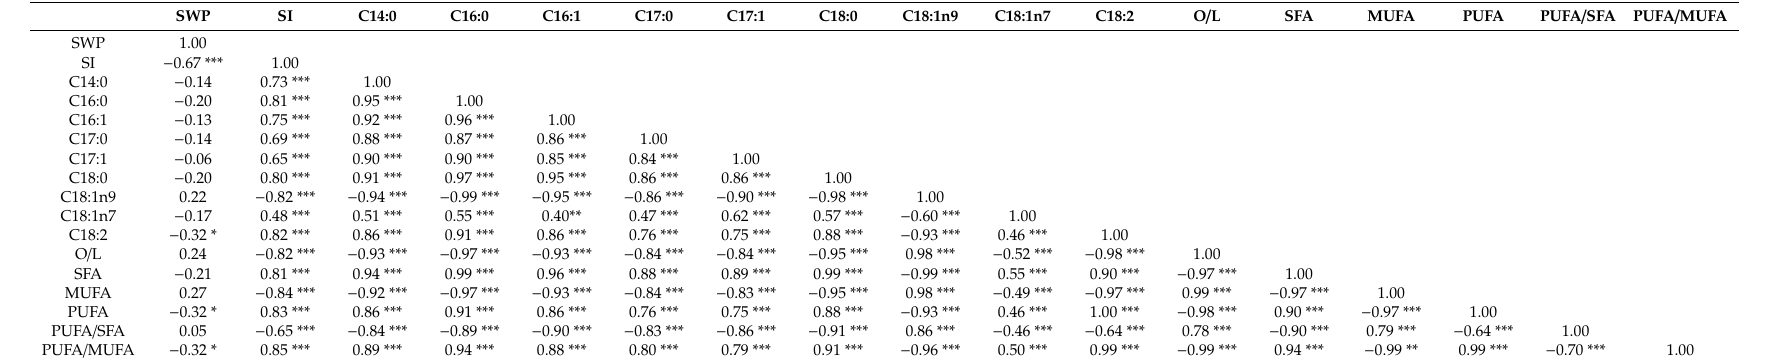
Table 4. Pearson’s correlation coe ffi cients (R) among stem water potential and stress integral with fatty